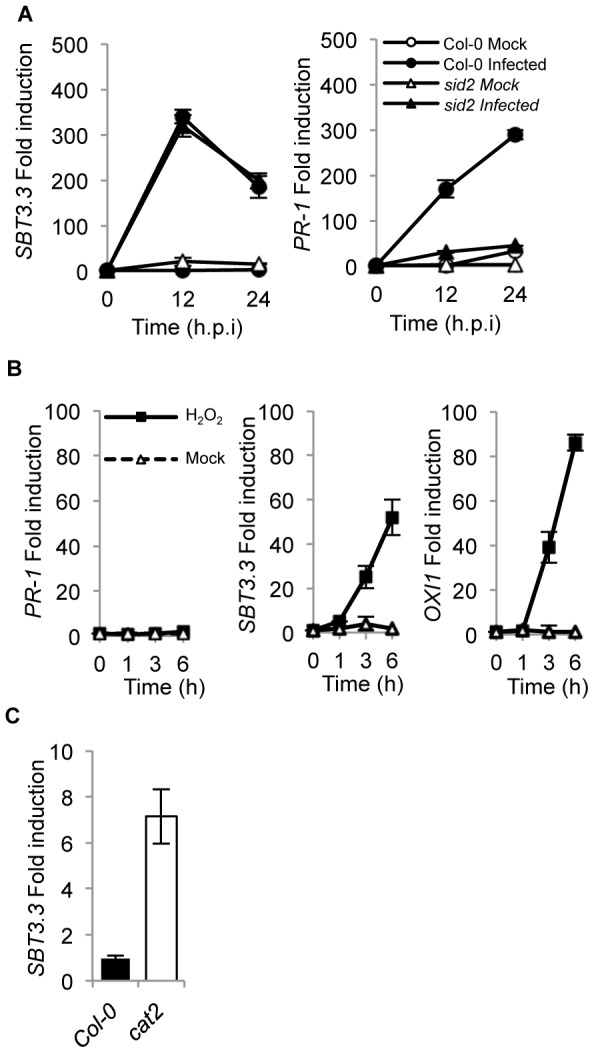

SBT3.3 gene expression is SA-independent and rapidly induced by H2O2.(A) RT-qPCR analysis showing SBT3.3 gene expression in mock- (white symbols) and PsDC3000 (AvrRpm1)-inoculated (black symbols) leaves in Col-0 (circles) and sid2-1 (triangles). (B) RT-qPCR analysis showing PR-1, SBT3.3 and OXI1 gene expression in mock- (white triangles), and H2O2-treated (black squares) Col-0 seedlings. (C) SBT3.3 expression level in a cat2 mutant. Data represent the mean ± SD; n = 3 replicates and gene expression given as in Fig. 1.